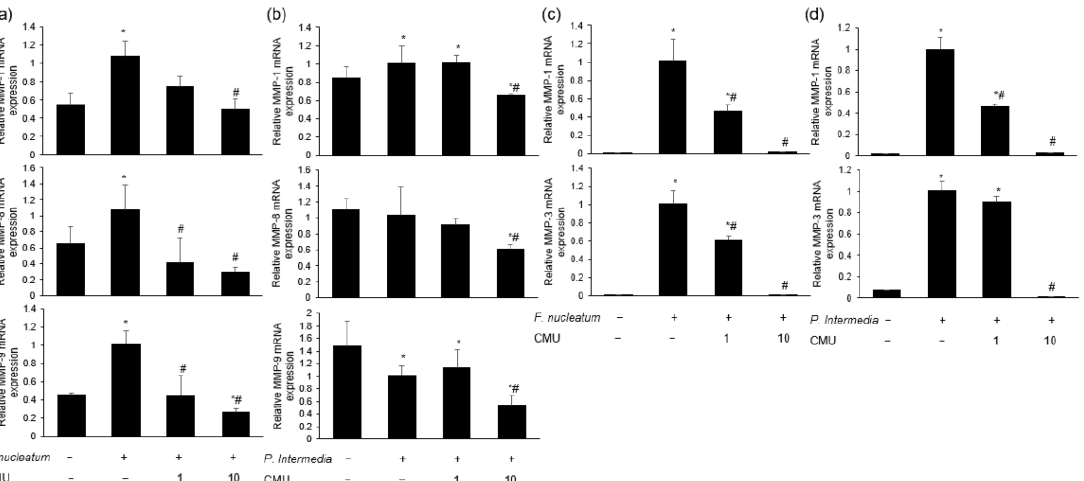
Figure 7. Dose-dependent effects of W. cibaria CMU on the mRNA expression of MMPs induced by F. nucleatum ( a , c ) and P. intermedia ( b , d ). HGFs were pre-treated with W. cibaria CMU for 30 min at doses of 1- and 10-times that of F. nucleatum or P. intermedia and then incubated with each periodontopathogen for 4 h ( a , b ) or 24 h ( c , d ). CMU, W. cibaria CMU. Data are presented as the mean ± standard deviation. * p < 0.05, compared to the untreated group. # p < 0.05, compared to the control